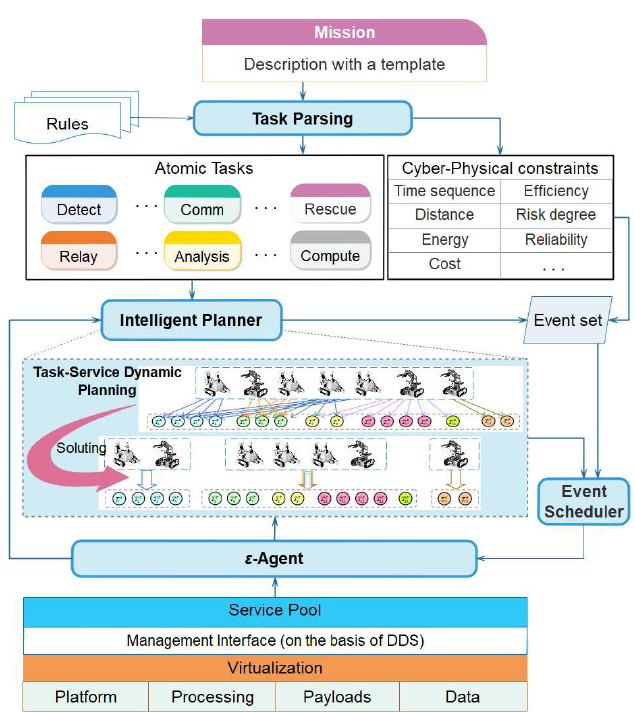
Figure 1. Virtualized-Service and Event-based Cooperation Architecture.